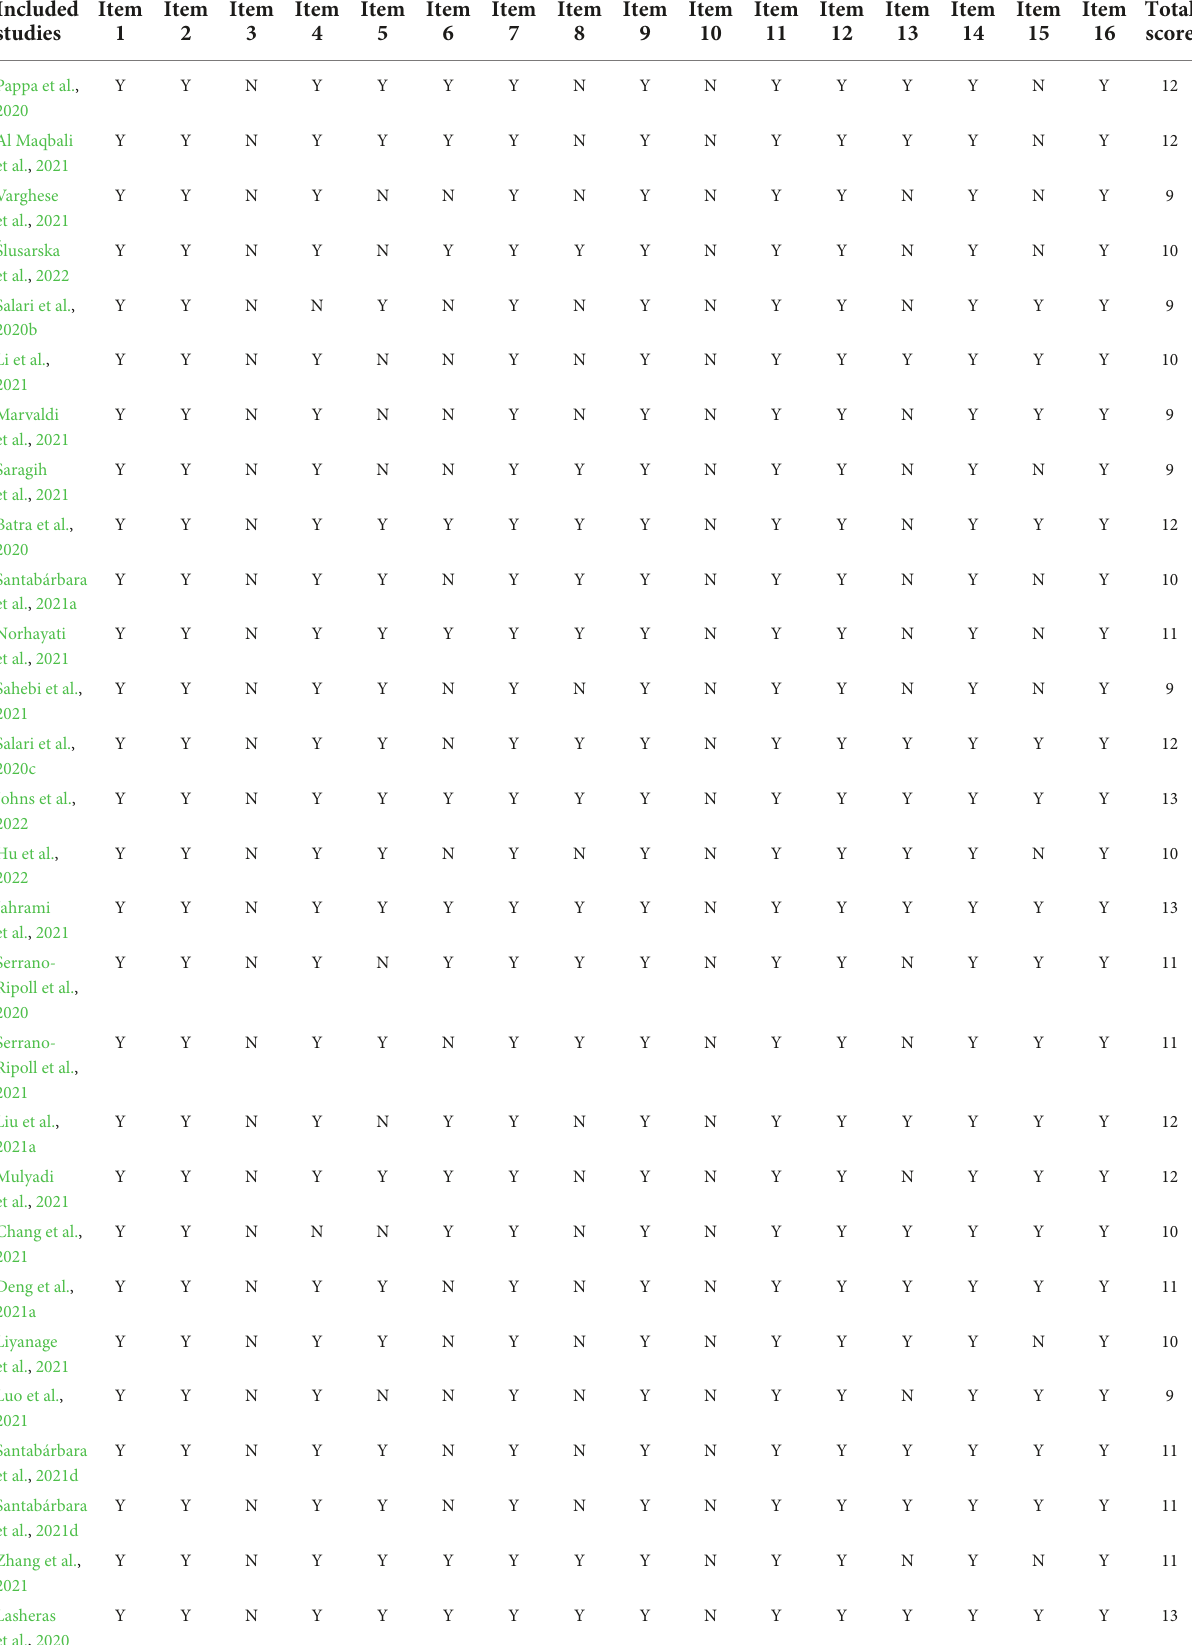
TABLE 2 A measurement tool to assess systematic reviews (AMSTAR 2) score for methodological quality of included systematic reviews. Included